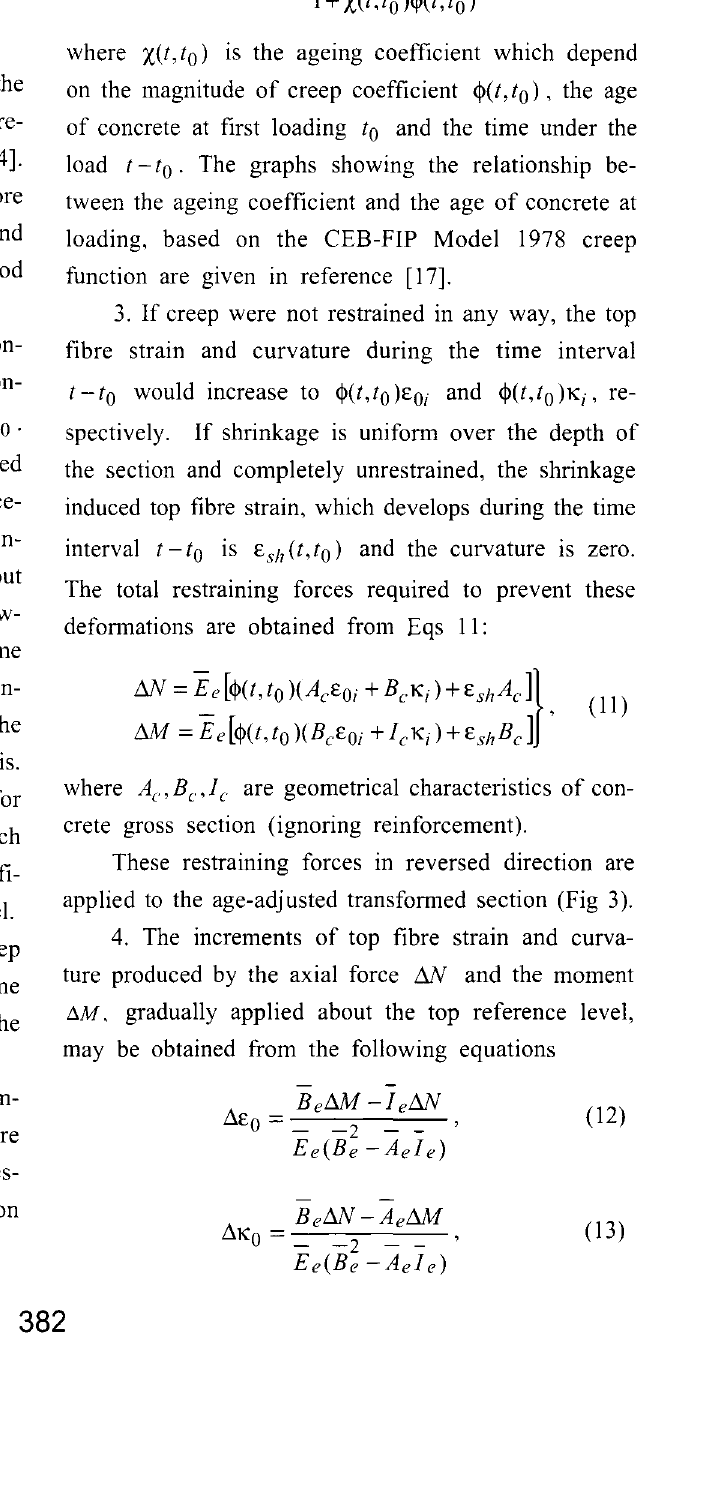
Fig 3. Deformations under long-term loading 2. Age-adjusted modulus of elasticity of